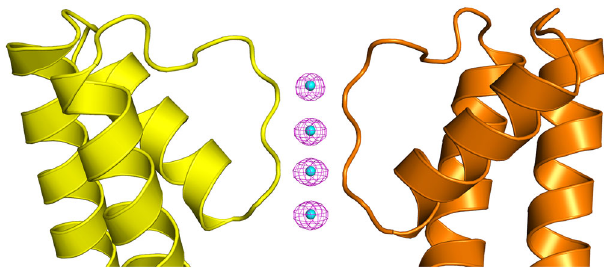
Fig. 2 Anomalous difference map. The anomalous difference Fourier map contoured at 8 σ is shown as a magenta mesh for subunit A. Strong